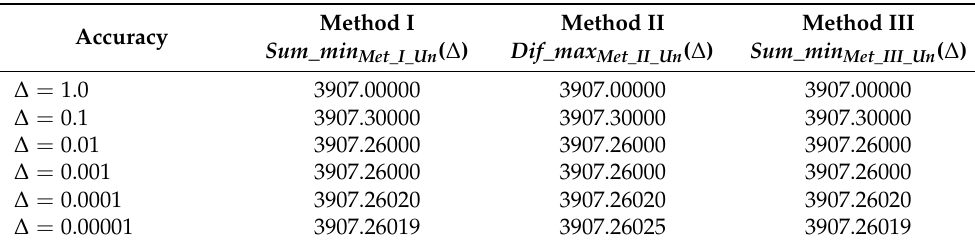
Table 11. Estimated lines lengths d ∆ of the reconstructed image for a given accuracy ∆ using the methods proposed by the authors.